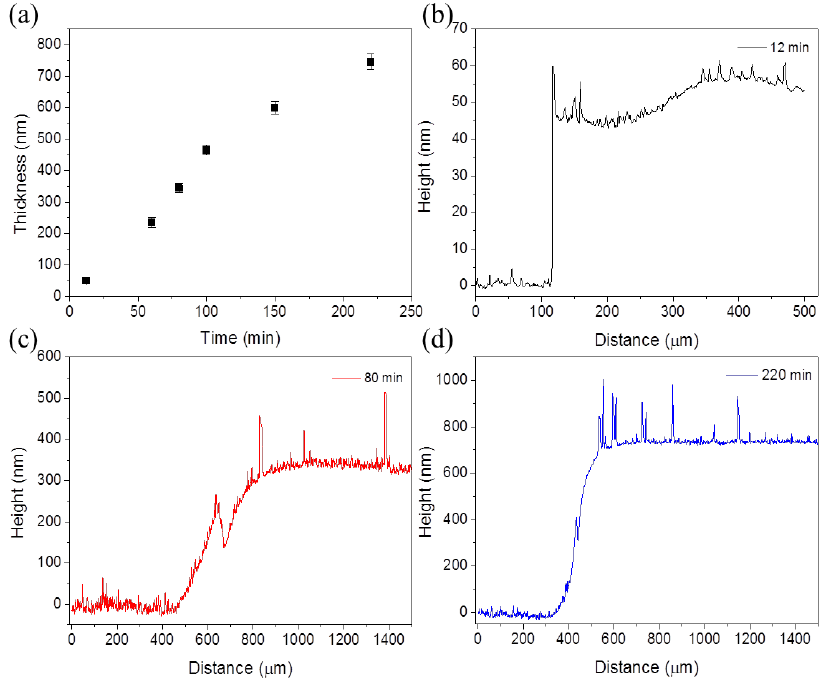
Figure 1. Thickness of the layers measured by profilometry: ( a ) relationship between thickness of the layer and sputtering time; height of the layer measured after ( b ) 12 min., ( c ) 80 min. and ( d ) 220 min. of sputtering.